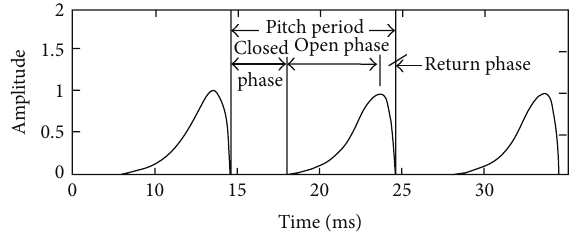
Figure 2: Periodic glottal airflow waveform